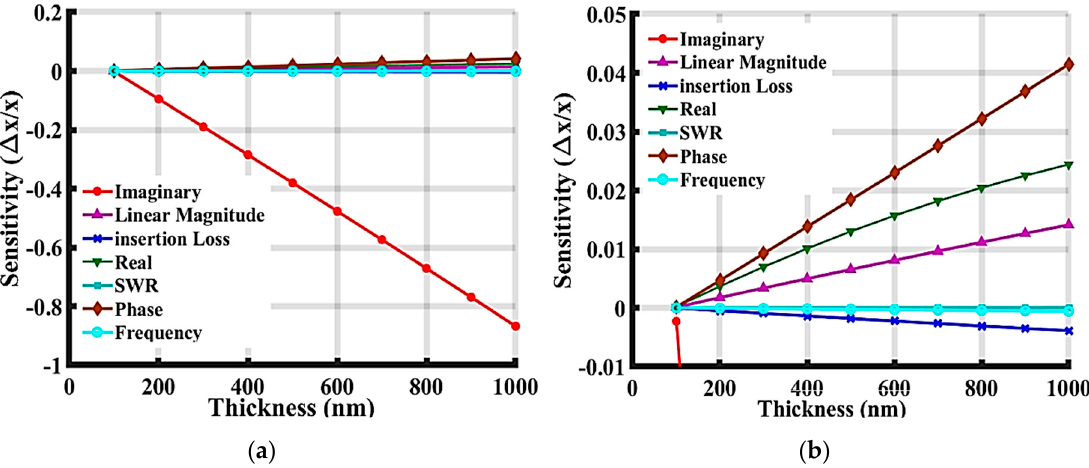
Figure 13. Comparison of normalized sensitivity defined based on different device parameters of the simulated SAW device with only ZnO layer. ( a ) Full view of the plot, and ( b ) zoomed figure without Imaginary data.